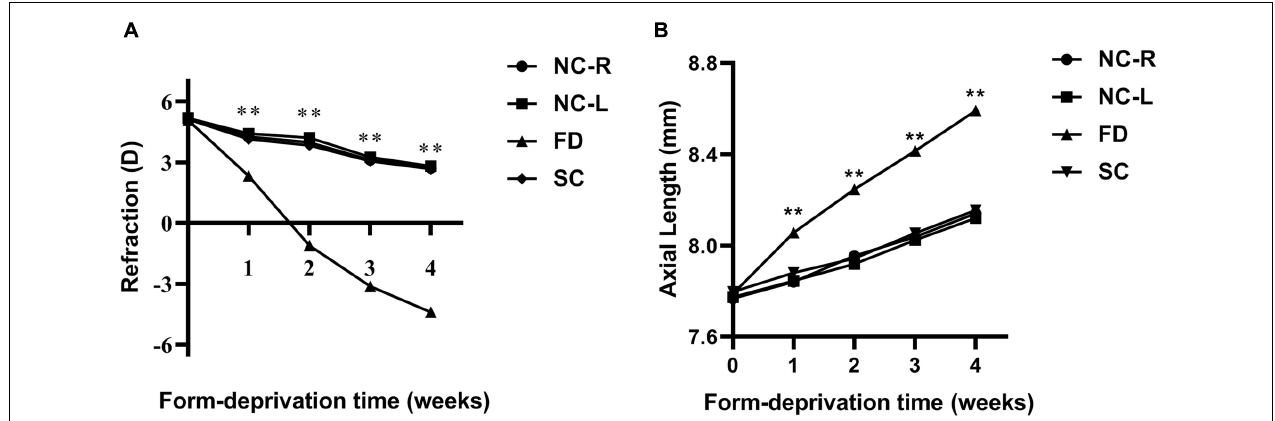
FIGURE 1 | Changes in refraction (A) and AL (B) in eyes of form deprivation guinea pigs. (** P < 0.01. FD, the right eye of the experimental group; SC, the left eye of the experimental group; NC-R, normal control right eye; NC-L, normal control left eye).